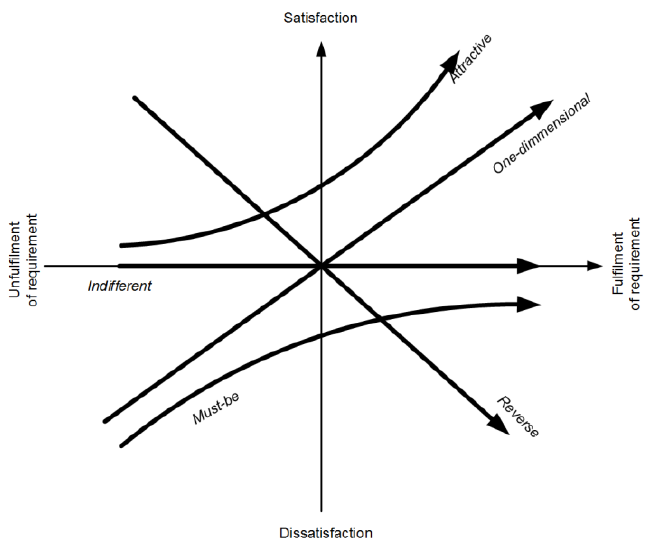
Figure 2. Kano model (Shahin et al. 2013).